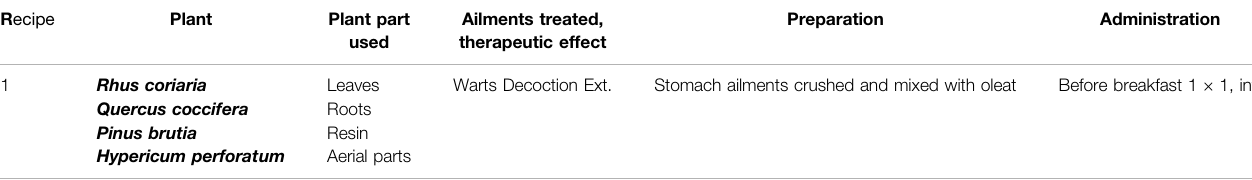
TABLE 3 | Multiherbal recipes used as folk medicine in Mersin.